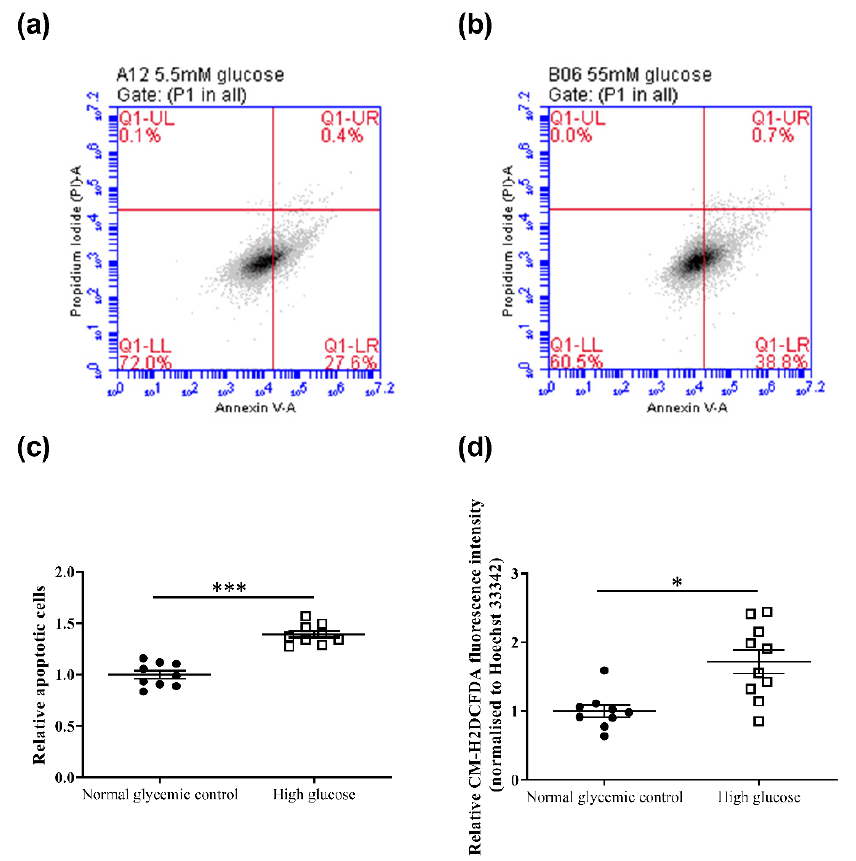
Figure 2. Effect of high-glucose apoptosis and ROS levels on the 661w cell line. Representative flow cytometry dot plots of cells incubated in ( a ) normal glycemic control and ( b ) high glucose for annexin V-PI counterstain. ( c ) Dot plots showing the relative change in cell apoptosis of 661w cells under the two conditions. ( d ) Relative change in ROS levels (CM-H2DCFDA fluorescence intensity normalized to Hoechst 33342 fluorescence intensity) of 661w cells in normal glycemic control and high glucose. (* p < 0.05, *** p < 0.001; data presented as mean ± SEM. n ≥ 9 (biological replicates)).